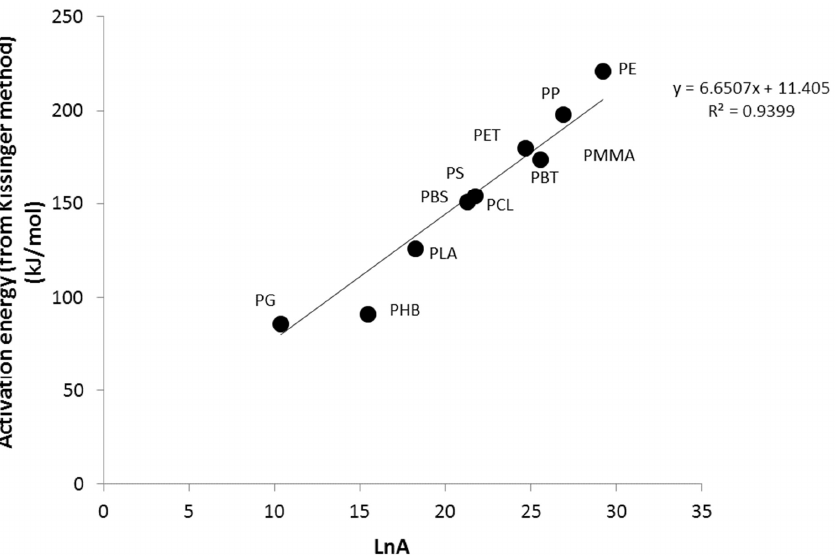
Figure 5. Activation energy versus LnA from the Kissinger method. The straight line is calculated Figure 5 – Activation energy versus Ln(A) from Kissinger method (straight line is calculated considering all polymers except PHB) considering all polymers except poly(3-hydroxybutyrate)